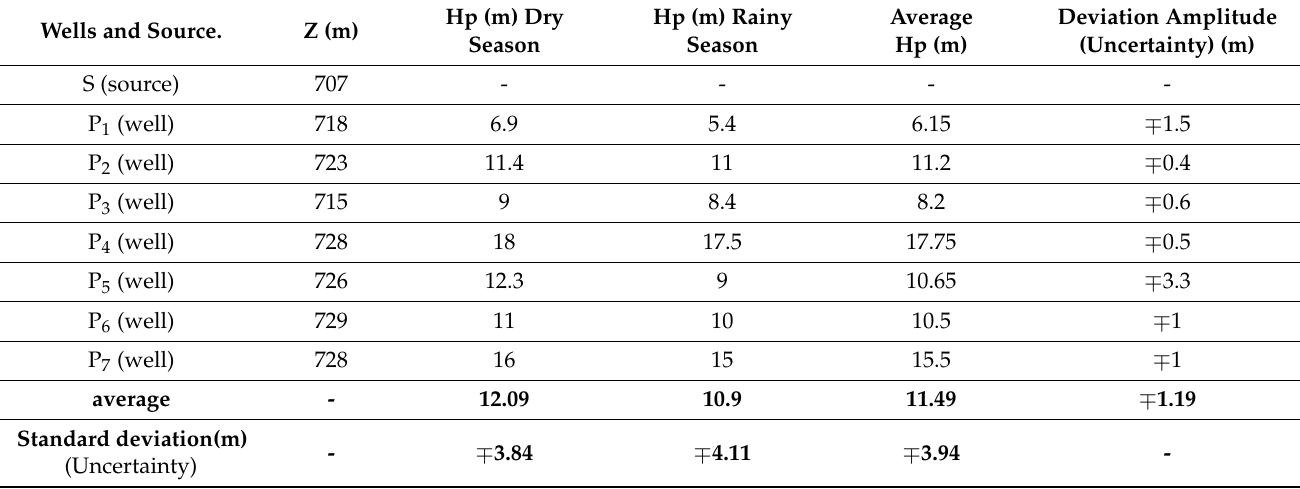
Table 1. Results of the static levels.